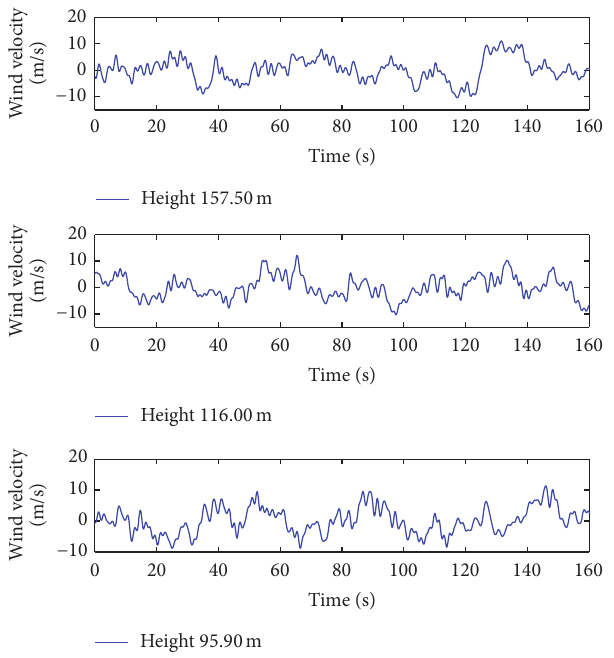
Figure 4: Velocity histories of fluctuating wind in x direction.